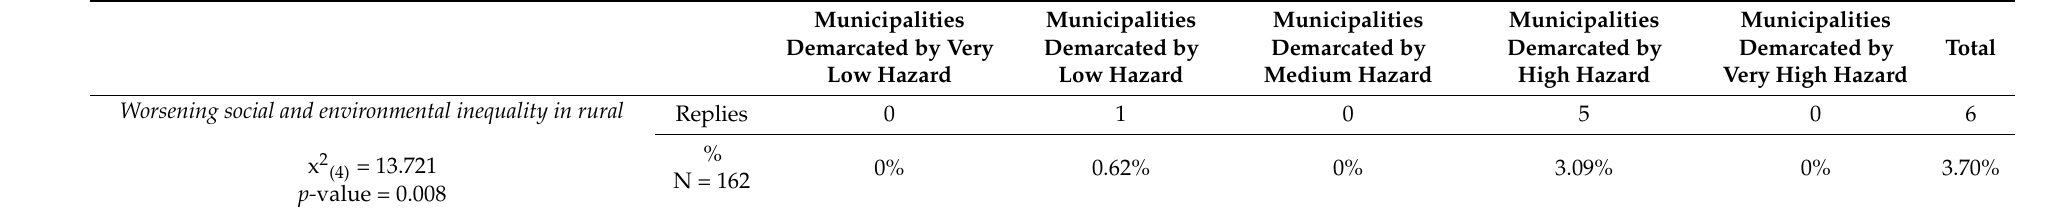
Table 5. Relationships with statistical significance established between the considered threat of worsening social and environmental inequality in rural communities and the influence of hazard in